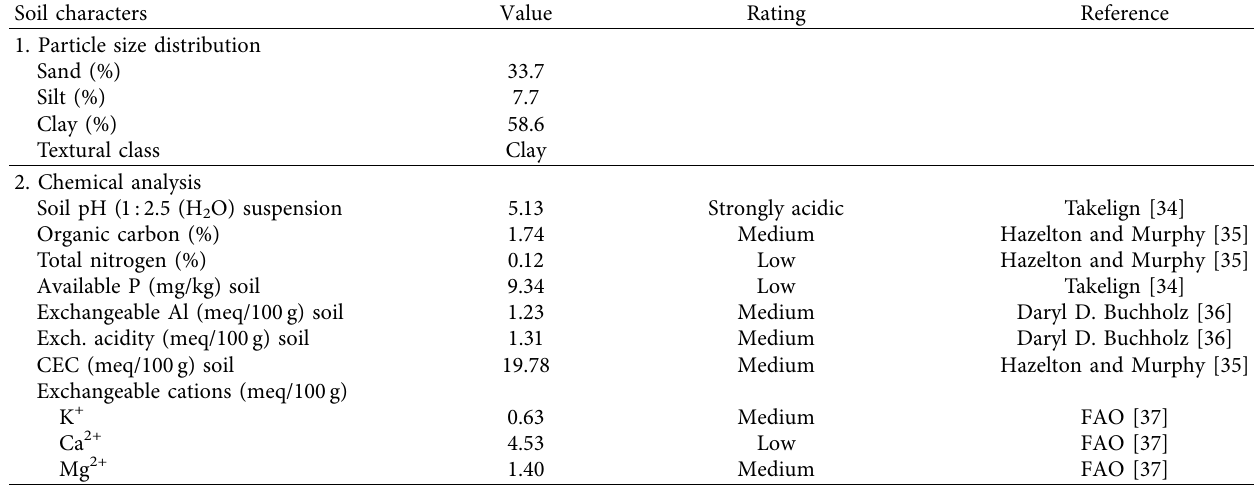
Table 1: Selected soil physicochemical properties of the experimental site before planting.